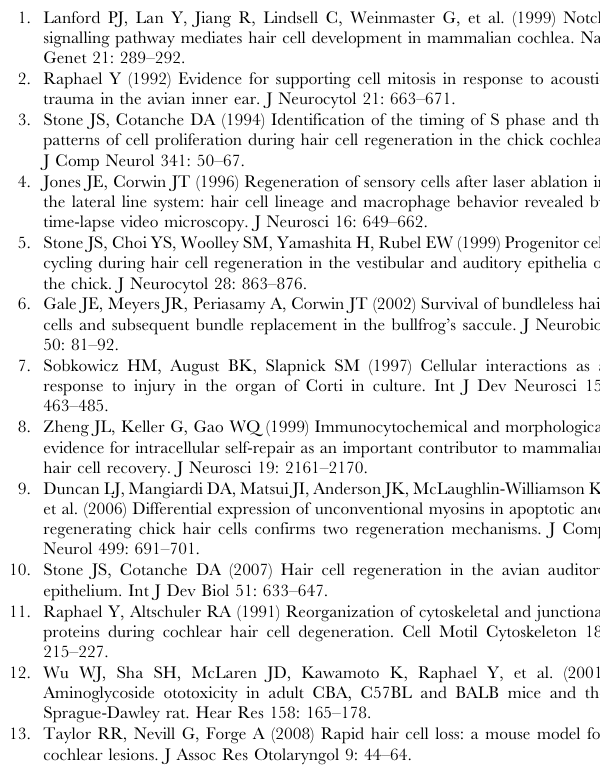
Table S2 The effects of culture time and location of OHCs on the number of OHCs. Table S3 The effects of culture time and treatment on the number of